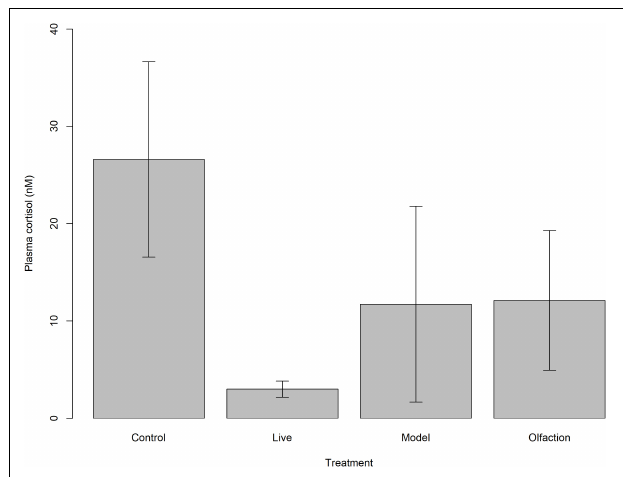
FIGURE 4 | Mean basal plasma cortisol (nM) levels with 95% confidence intervals in lumpfish ( n = 24) after 6 weeks of treatment exposure. Treatments involved interaction with two Atlantic salmon (Live), two salmon models (Model) or salmon smell from a tank containing four Atlantic salmon (Olfaction).